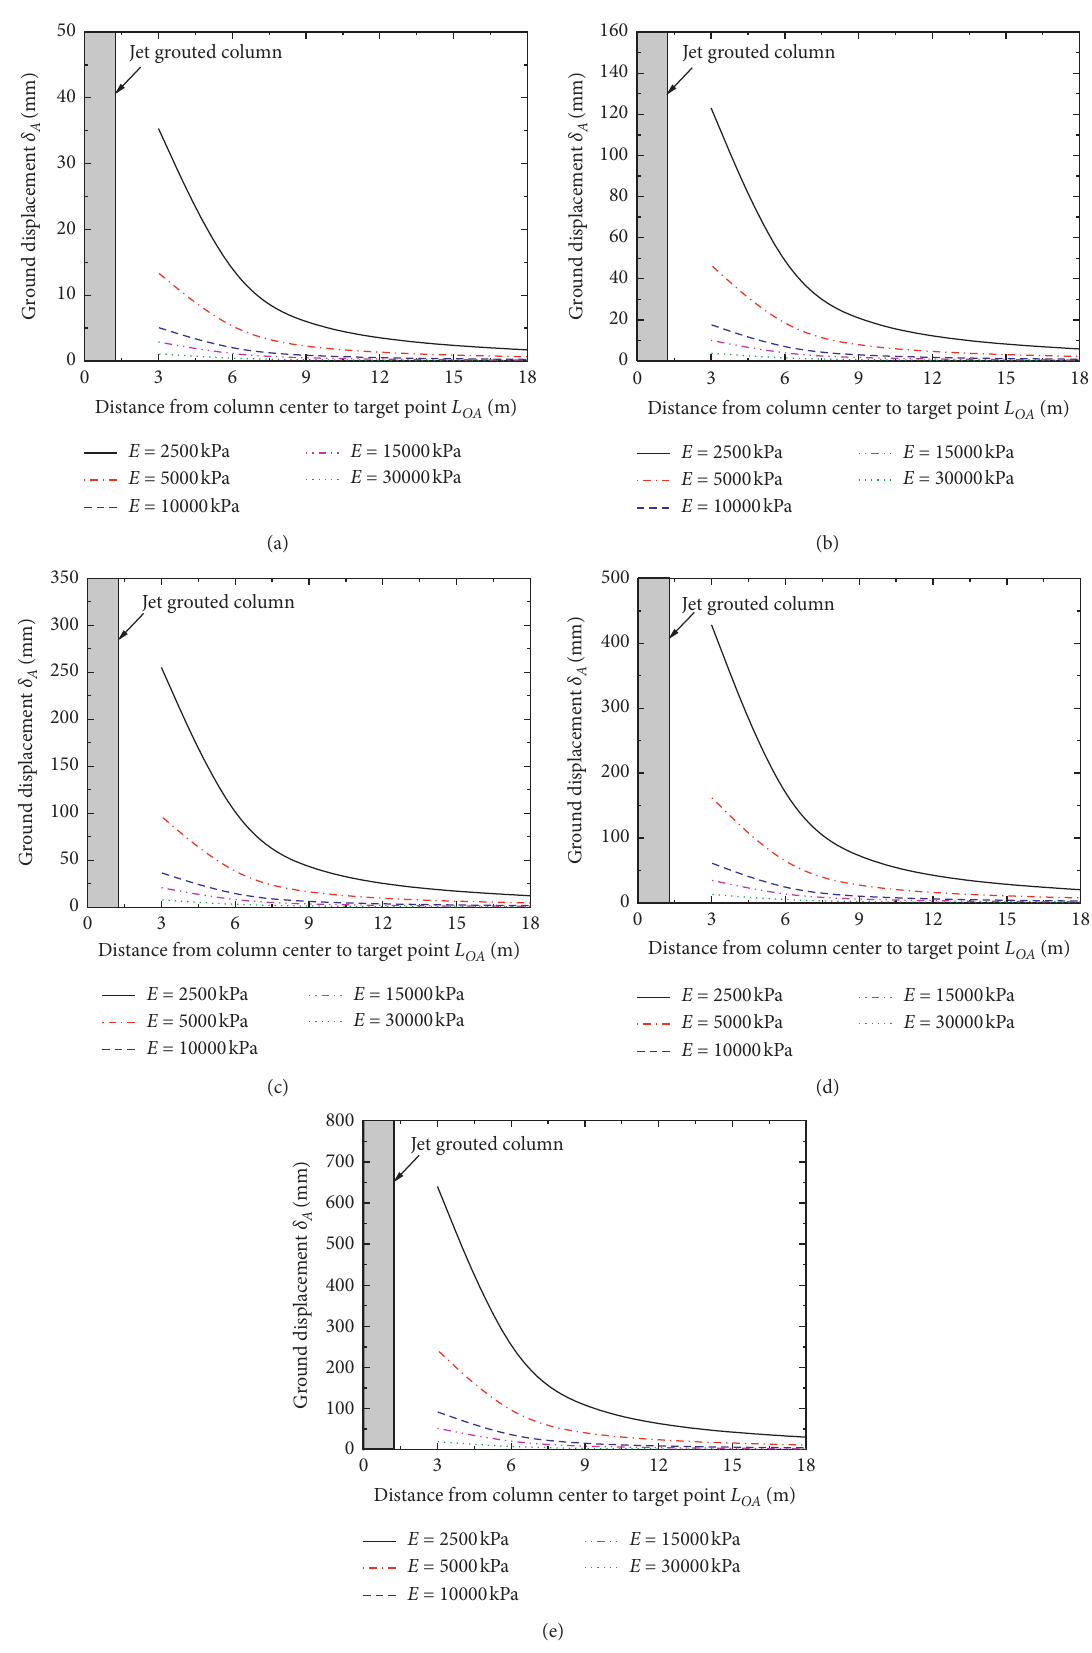
Figure 6: Design charts for estimating ground displacement caused by installing a jet grouted column: (a) R R c � 0.75m; (d) R c � 1.00m; (e) R c � 1.25